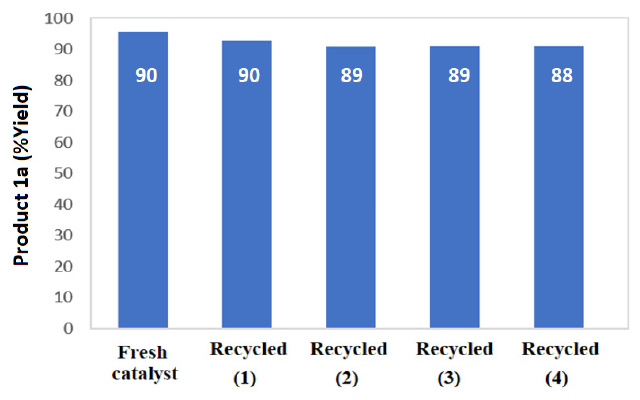
Figure 6. Recyclability of CS-CuO (15 wt.%) nanocatalyst in synthesis of product 1a . By summing up the data from the optimization, the best result was obtained by em- ploying CS-CuO (15 wt.%), at 120 °C for 3 h in (1:5) EtOH-H 2 O as the solvent.